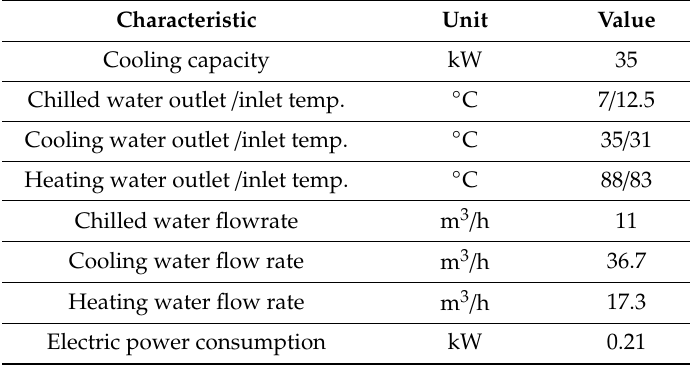
Table 3. Specifications of the YAZAKI WFC-SC10 absorption chiller